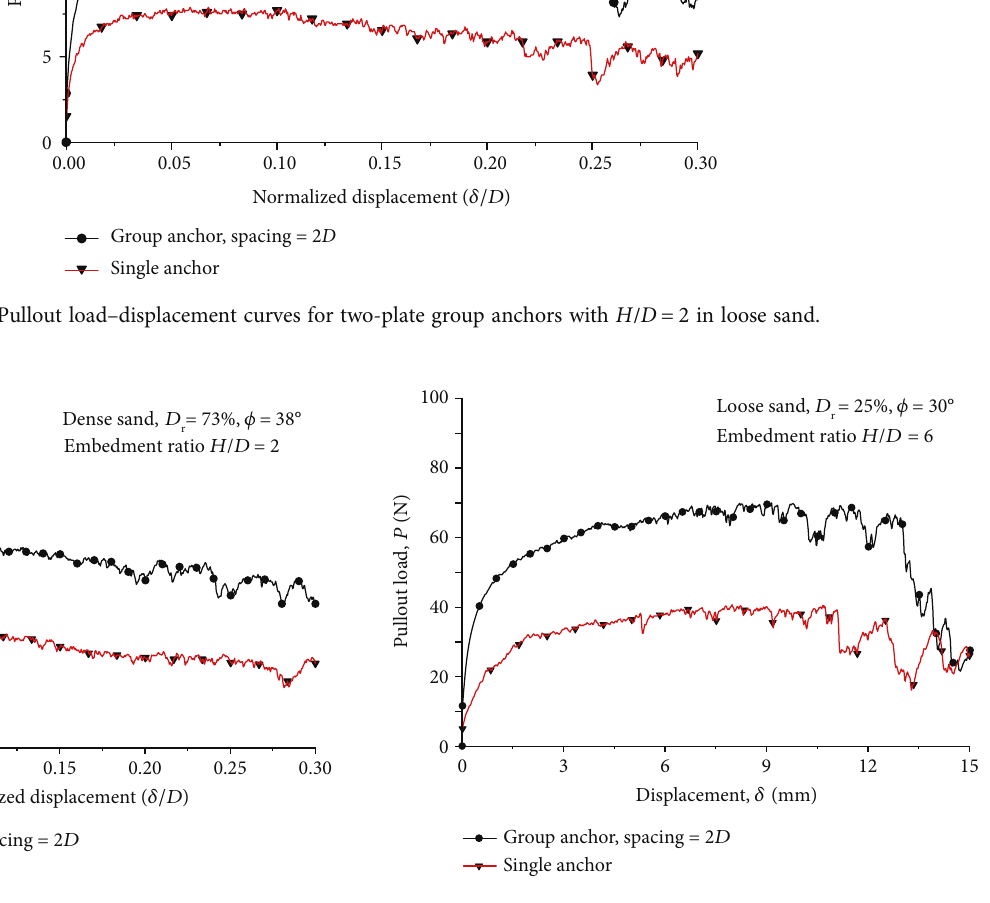
Figure 3: Pullout load – displacement curves for two-plate group anchors with H / D = 2 in dense sand.